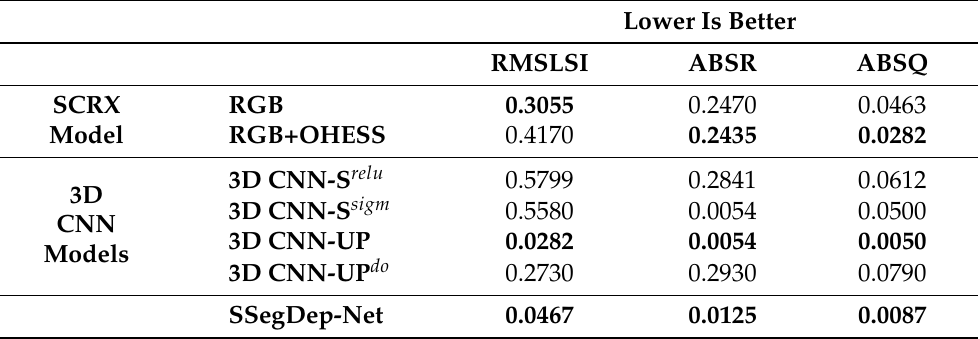
Table 3. Quantitative results using the RMSLSI, ABSR, and ABSQ error metrics (see the Appendix A. 3D CNN-S relu uses ReLU in the last layer, 3D CNN-S sigm uses sigmoid in the last layer, and 3D CNN-UP do adds dropout).